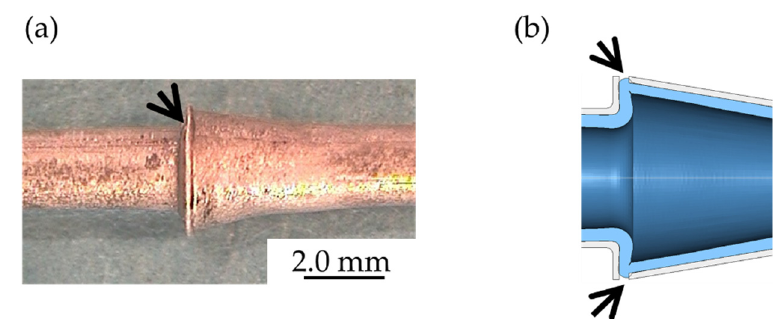
Figure 19. Forming defect of the small ZM21 tube in the taper-shape warm THF: ( a ) experiment; ( b ) FEM.